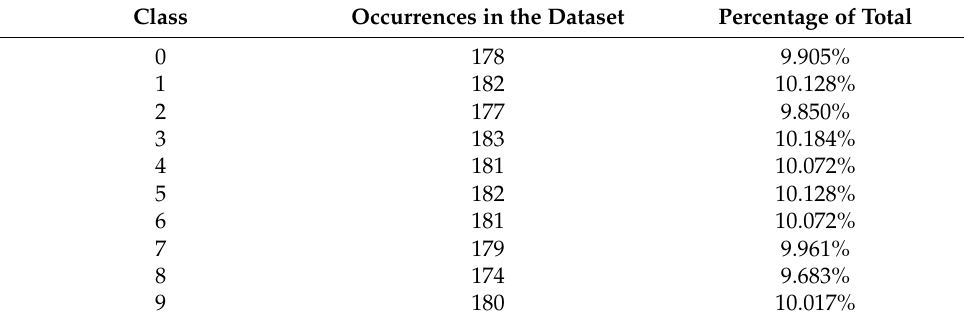
Table 1. Output classes